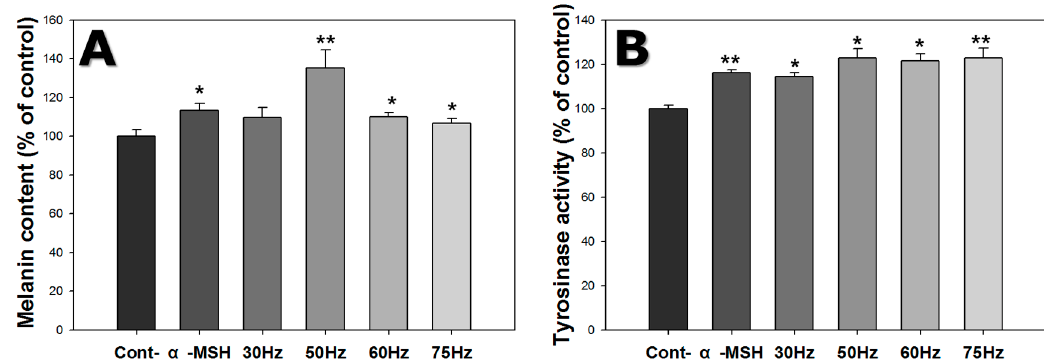
Figure 4. Effect of extremely low frequency electromagnetic fields (ELF-EMFs) on melanogenesis of melanocytes after exposed to ELF-EMFs for 72 h. After ELF-EMFs exposure, melanin content and tyrosinase activity were determined. ( A ) Melanin content was detected by the melanin content assay; ( B ) Tyrosinase activity was measured by the tyrosinase assay. Each bar represents the mean ± standard error of independent experiments performed in triplicate ( n = 3). * p < 0.05, ** p < 0.01, compared to the control.